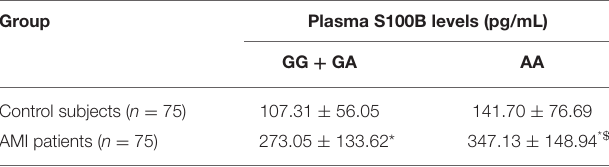
TABLE 5 | Plasma S100B levels in subgroup subjects according to S100B rs9722 G/A genotypes.